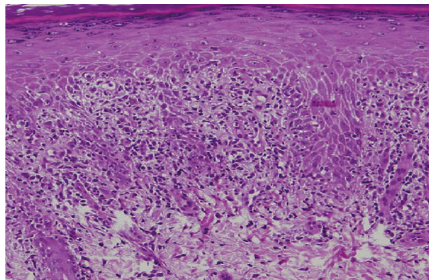
Figure 1: Photomicrograph of hypertrophic lichen planus showing acanthosis, lichenoid mononuclear dermal infiltrate, and colloid bodies (H&E × 40).